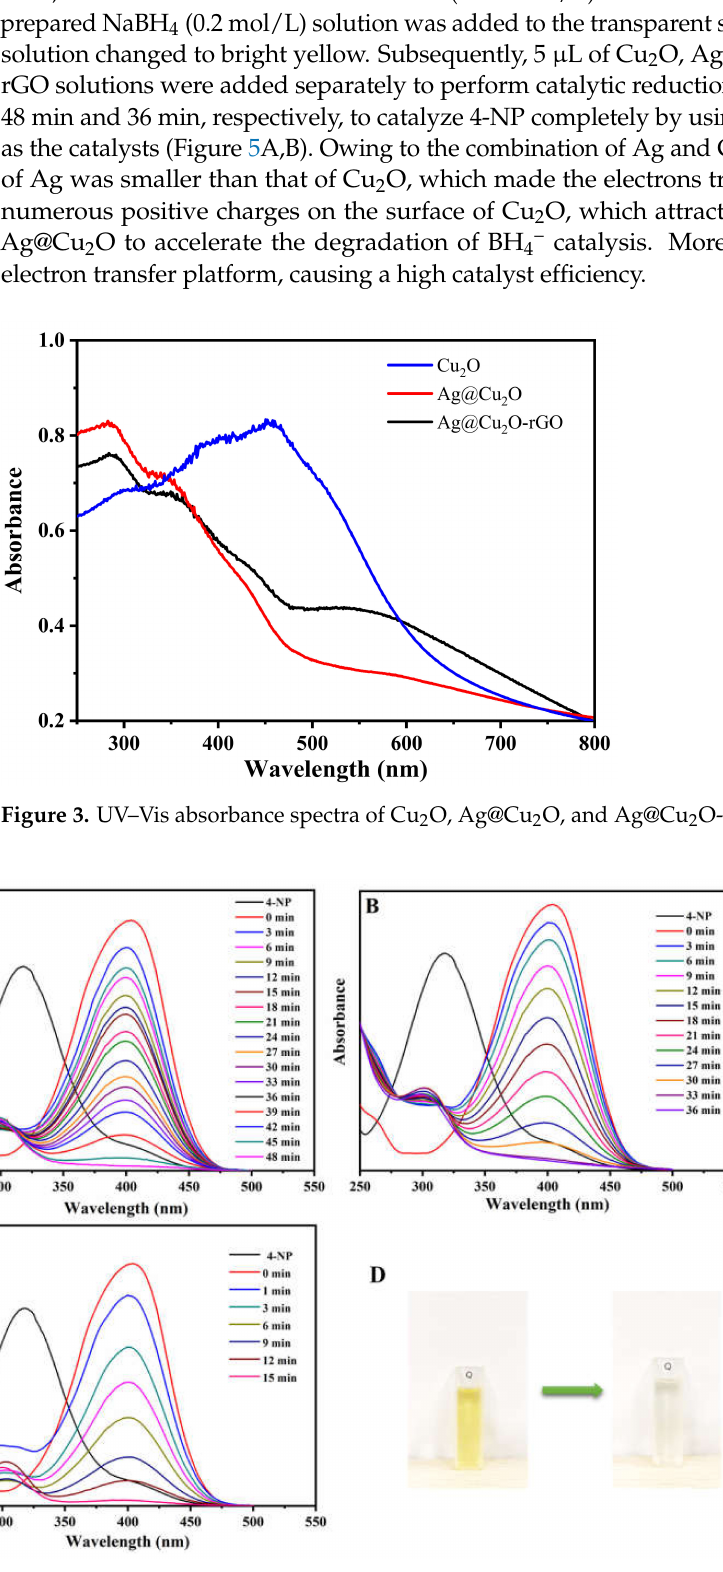
Figure 4. UV–Vis absorption spectra of the reduction of 4-NP by NaBH 4 in the presence of ( A ) Cu 2 O (t = 48 min), ( B ) Ag@Cu 2 O (t = 36 min), and ( C ) Ag@Cu 2 O-rGO (t = 15 min). ( D ) Photographs of the catalytic reduction of 4-NP by NaBH 4 in the absence and presence of Ag@Cu 2 O-rGO (t = 15